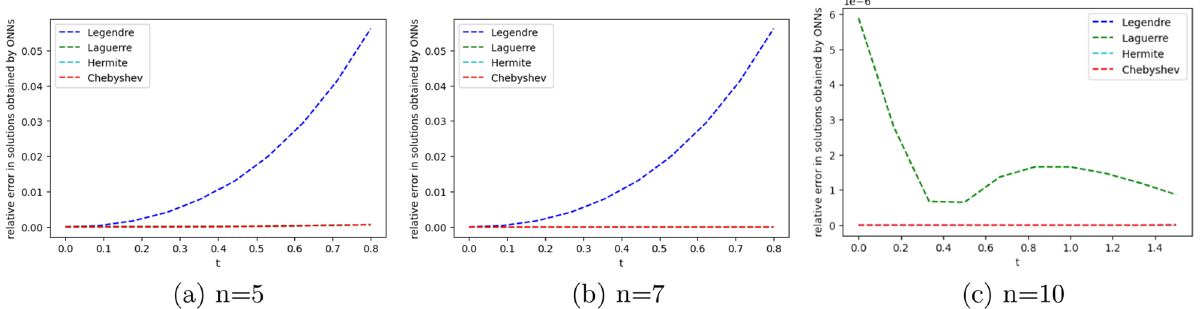
Figure 15. Error graph of z 2 ( t ) for different orthogonal neural networks with different numbers of neurons for Example 7.2.